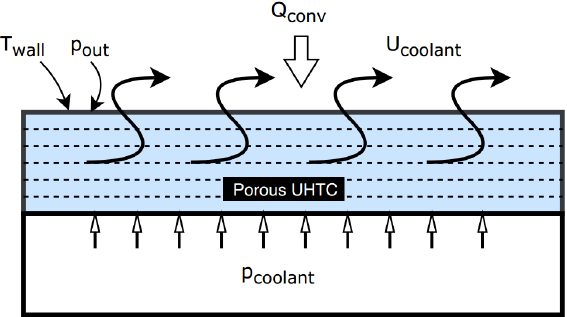
Figure 1. Schematic of transpiration